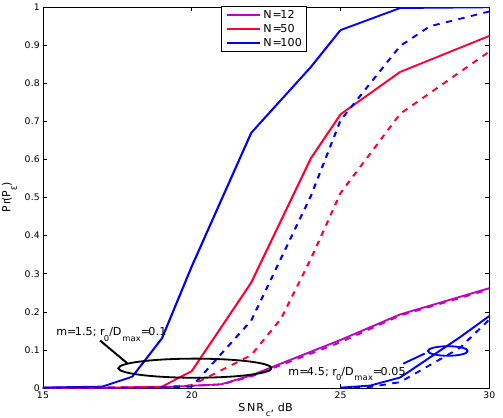
Fig. 5. Graphs of probability of validity of (12)-(14) versus the SNRc of the control channel. Dashed lines represent scenarios with γ0 = −10 dB, and solid lines correspond to cases of fully connected network graphs. The PU SNR =30